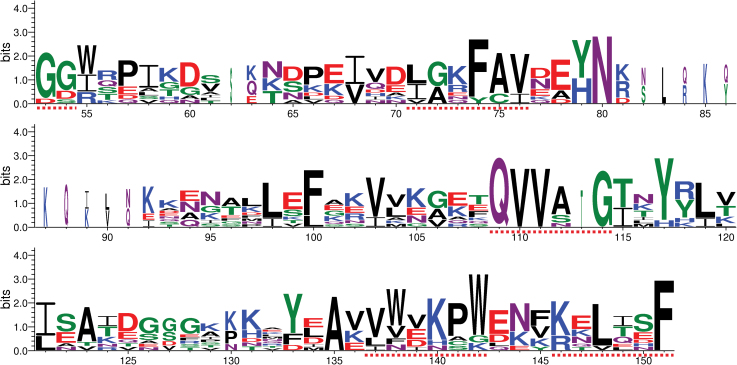
Conserved motifs in tobacco cystatins. Conserved motifs in cystatins are labelled with dotted lines, and the number under the character of amino acids indicates the position of amino acids in the protein sequences corresponding to that in Supplementary Fig. S1 at JXB online. (This figure is available in colour at JXB online.)